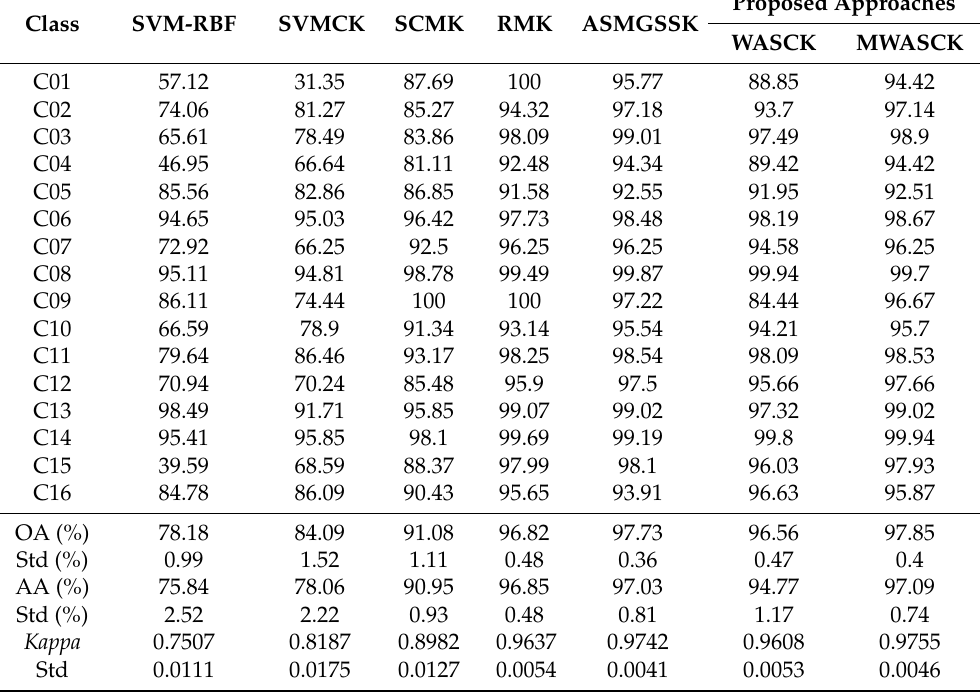
Table 2. Classification accuracy for the Indian Pines dataset.